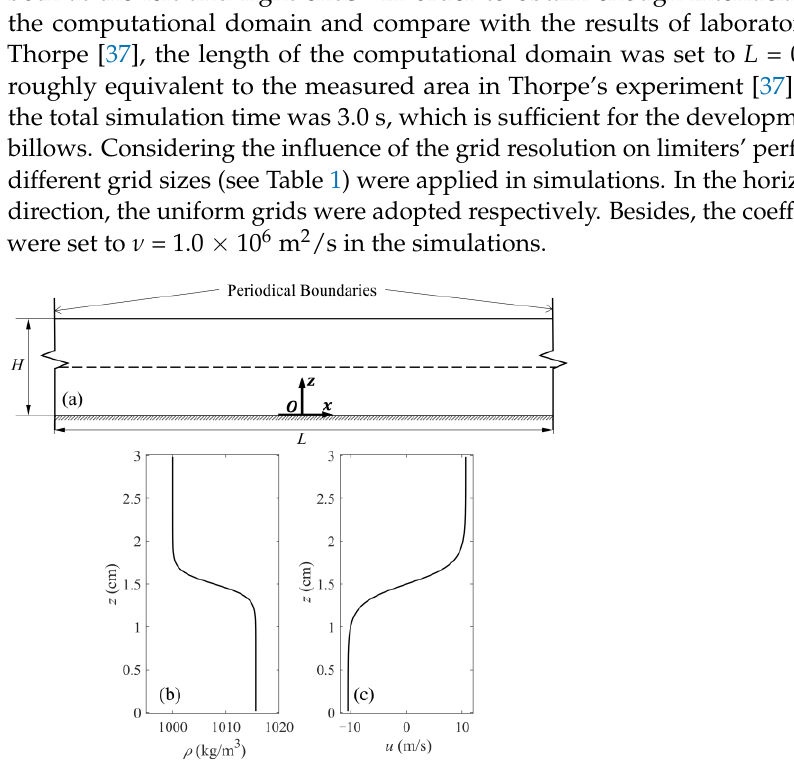
Figure 6. ( a ) Schematic of the domain and the boundary condition, ( b ) initial density profile, and ( c ) horizontal velocity profile for the shear instability case.